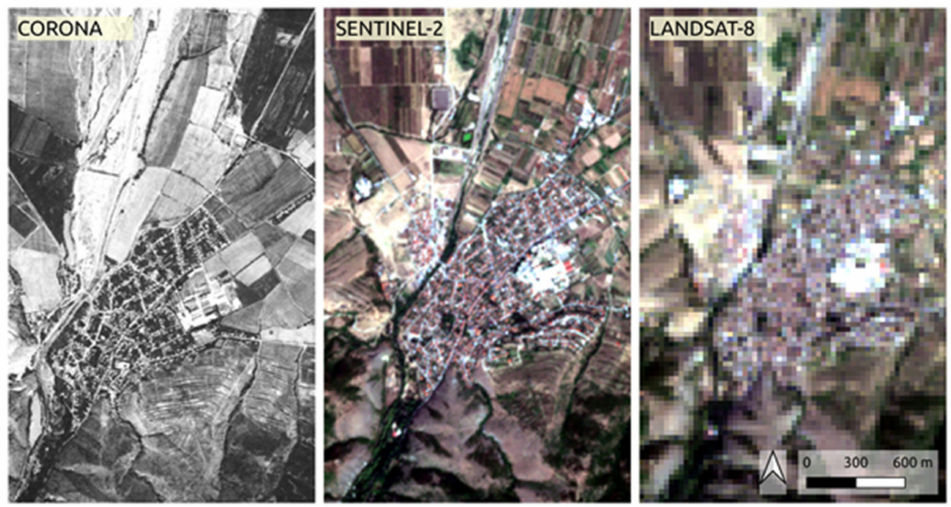
Figure 8. Comparison of the spatial resolutions of a 2.6m panchromatic Corona image acquired on 17 August 1968 (scene ID DS1104-2155DF040 available from the Earth Resources Observation and Sci- ence (EROS) website), a 10 m true-color representation Sentinel-2B image acquired on 29 August 2019 (scene ID S2B_MSIL1C_20190829T090559_N0208_R050_T35TLG_20190829T112604 available from the Copernicus Open Access Hub) and a 30 m true-color representation Landsat-8 image acquired on 21 August 2019 (scene ID LC81830312019233LGN00 freely available from the EarthExplorer website) over the settlement of Parvenets, Bulgaria. All image data sources presented are freely available to download from the respective